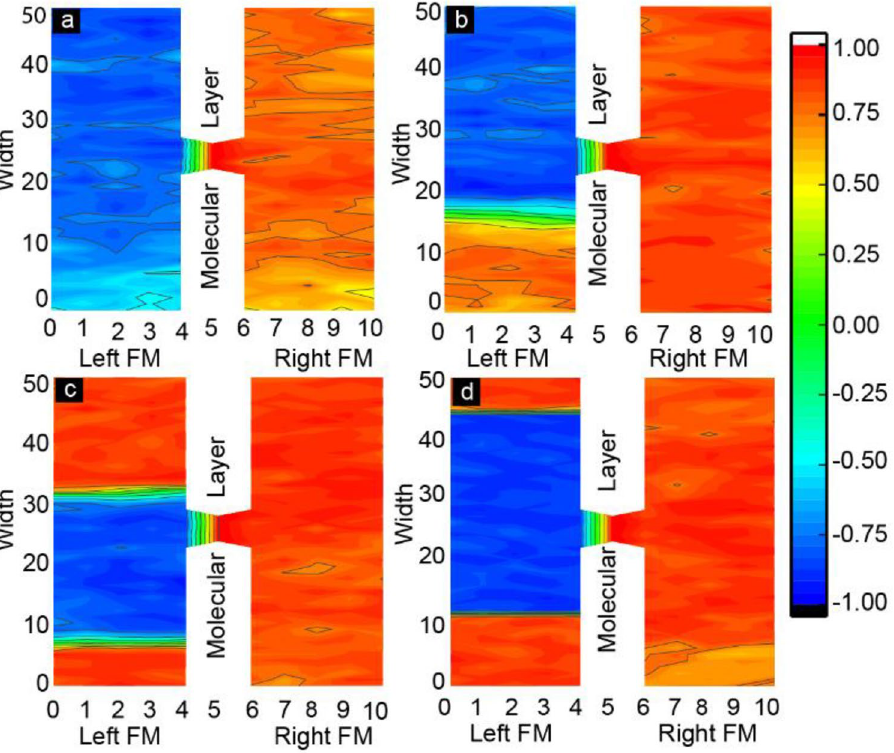
Figure 4. Molecule correlated FM electrode phases shown in the spatial-correlation factor contour plots of MTJMSD. SC is plotted for right and left FM electrodes and the magnetic molecule when ( a ) A LY = 0, ( b ) A LY = 0.1, ( c ) A LY = 0.4 and ( d ) A LY =1. ( d ) Is for Aly 1 or